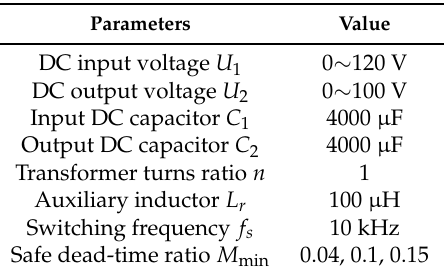
Table 4. Main Parameters of DAB